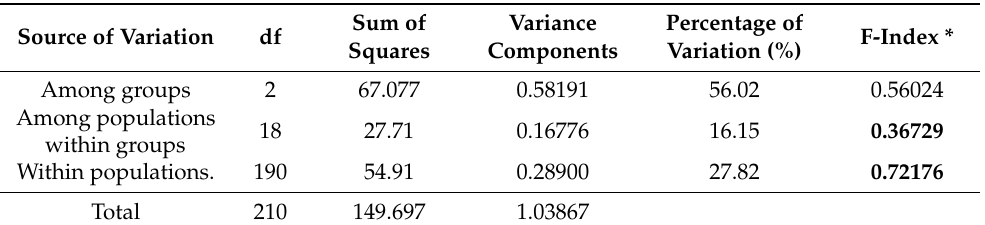
Table 2. Analysis of Molecular Variance of Aedes albopictus with concatenated sequences of mito- chondrial DNA.